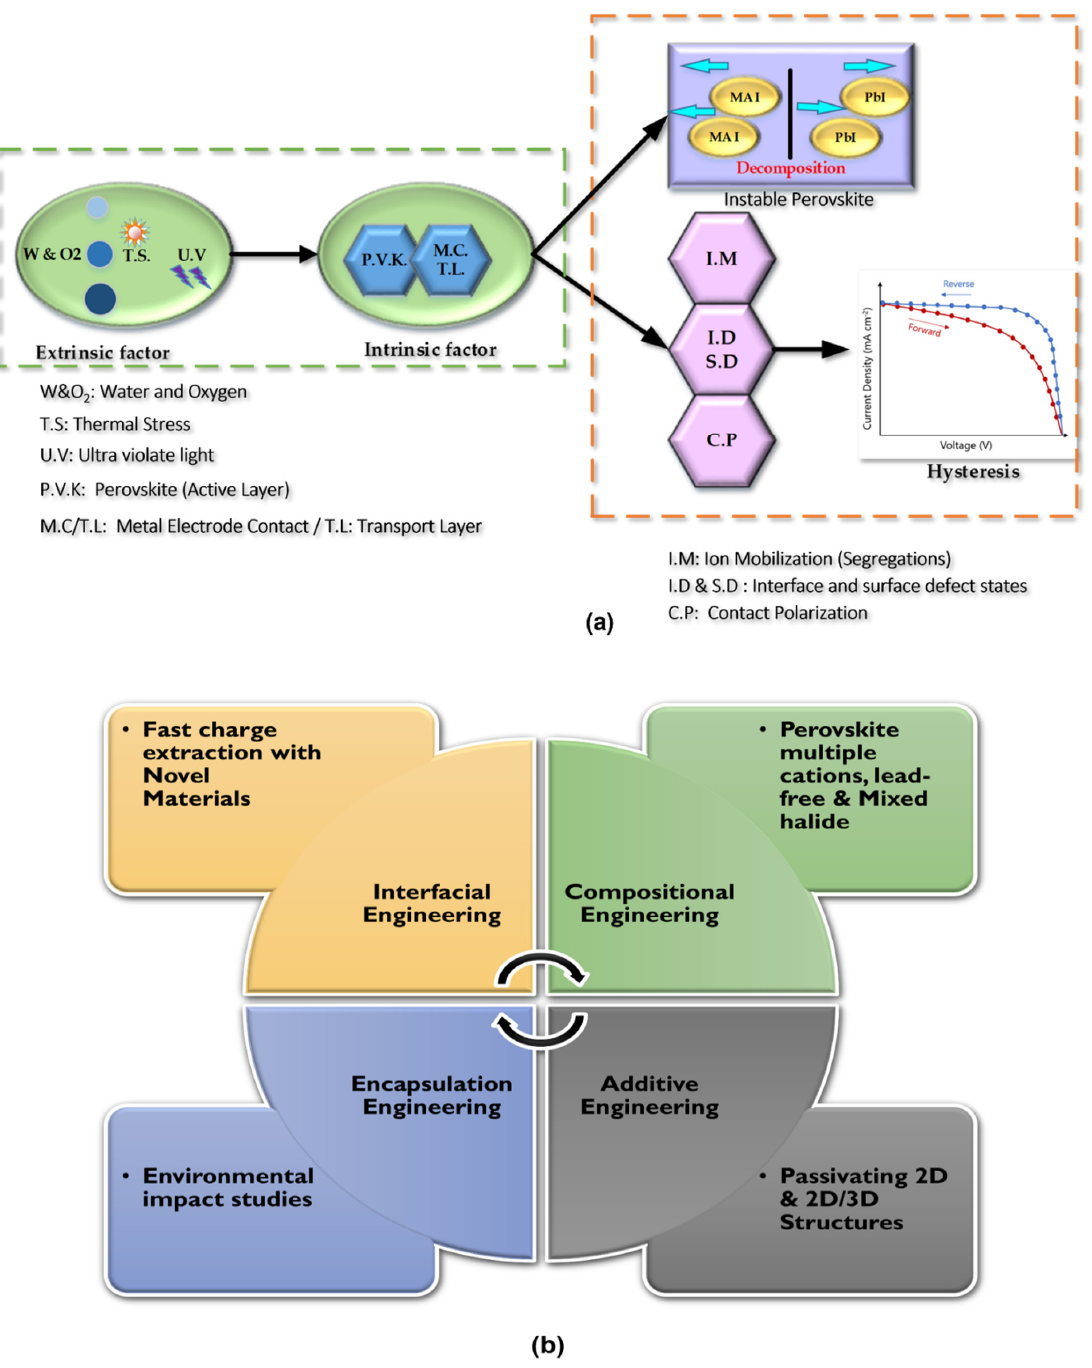
Figure 4. Schematic diagram of ( a ) the simple interplay between extrinsic and intrinsic perovskite performance degradation mechanisms with blue line arrows. The consequence of direct and indirect chain reactions is represented in red and green arrows, respectively. Hysteresis symbolic graph is depicted from Ref. [127]. ( b ) Summarizes the various perovskite engineering methods adopted in Table 4.